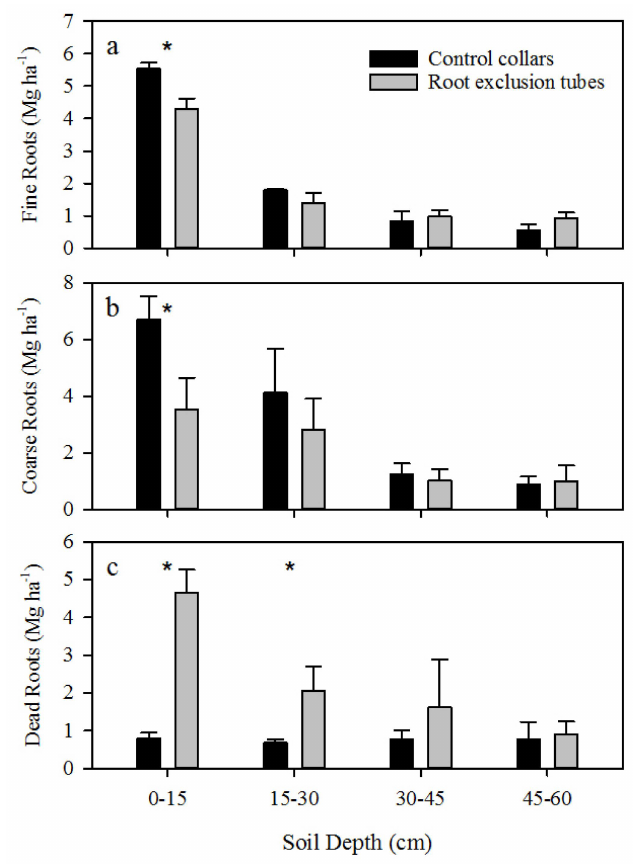
Figure 4. Root biomass by treatment and depth for ( a ) live fine; ( b ) live coarse; and ( c ) dead root categories measured in three 26-year-old longleaf pine ( Pinus palustris Mill.) stands. Note: Asterisks (*) denote significant treatment effects at α = 0.05. Error bars are ˘ 1 SE (standard